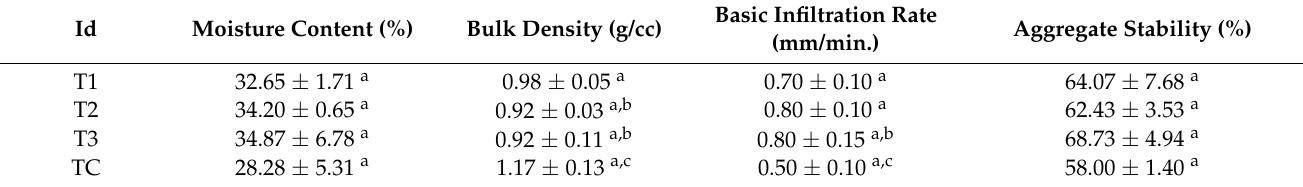
Table 2. Effect of treatments on physical